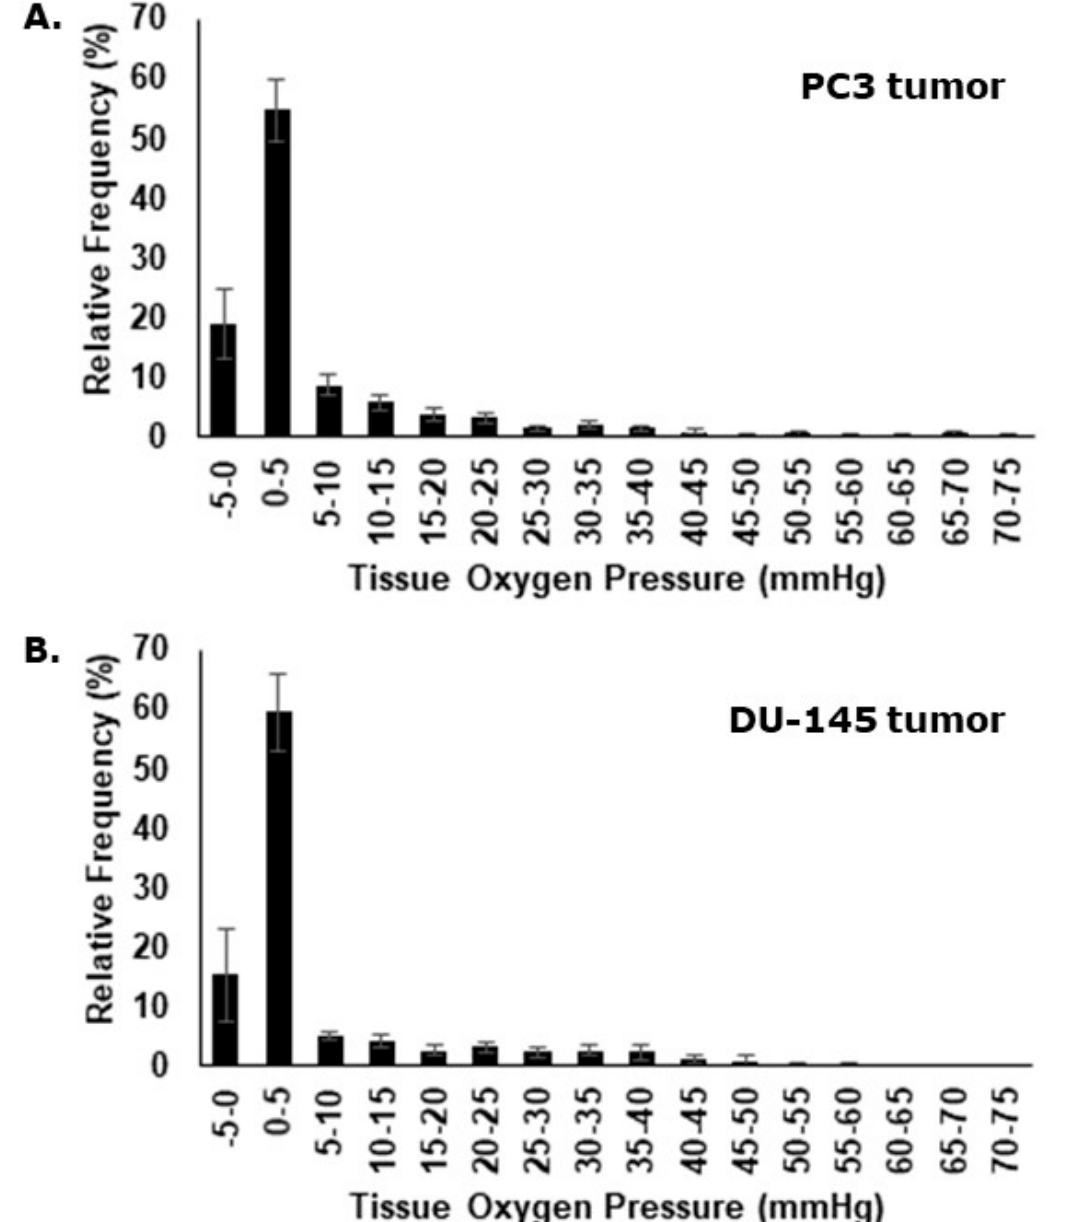
Figure 4. Representative histograms showing the oxygen partial pressure (pO 2 ) profiles obtained with the Eppendorf oxygen electrode in PC3 ( A ) or DU-145 ( B ) xenografts. Results show the means ( ± 1 S.E.) of the relative frequency of the various pO 2 values measured in individual flank tumors from eight (PC3) or 10 (DU-145) tumor-bearing mice. Both tumor types were very hypoxic.